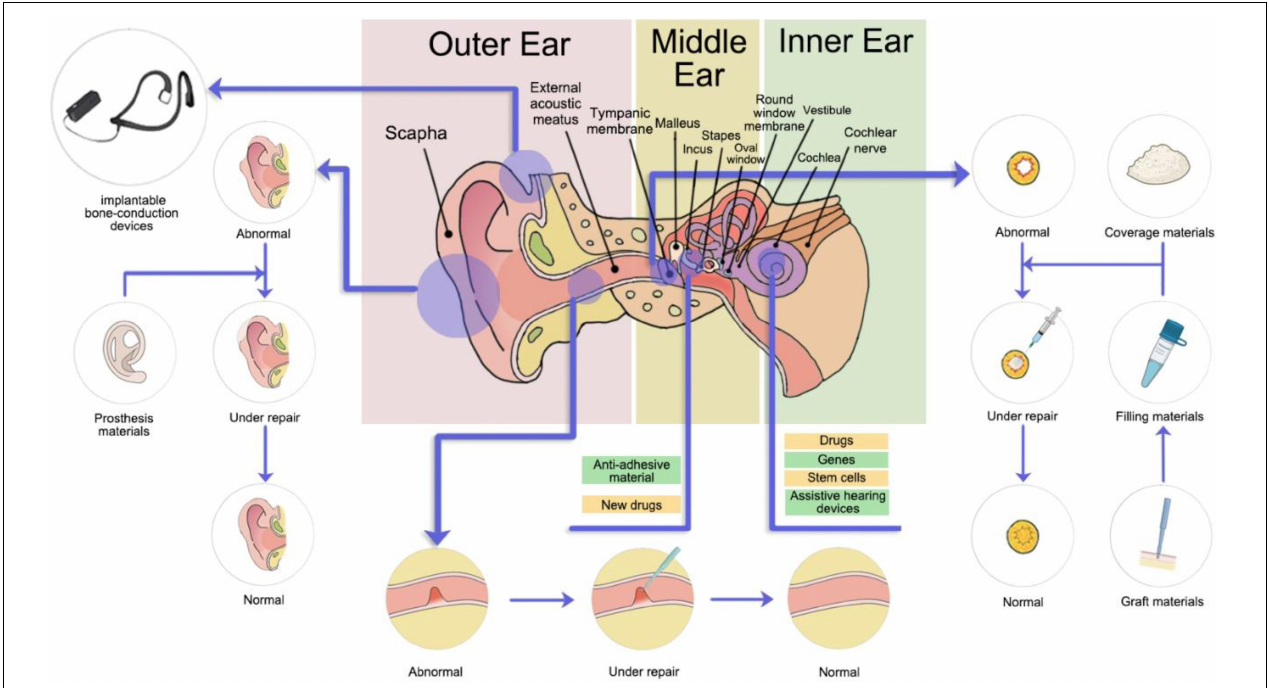
FIGURE 1 | Treatment sites of new materials for auditory